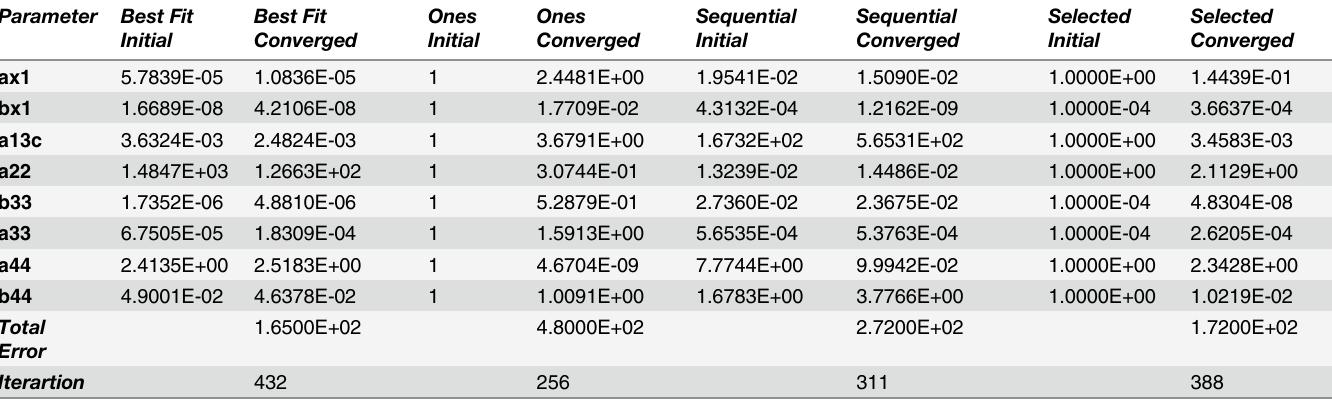
Table 4. Summary data of charged flecainide parameters starting from different initial conditions. Parameter Best Fit Best Fit Initial Converged